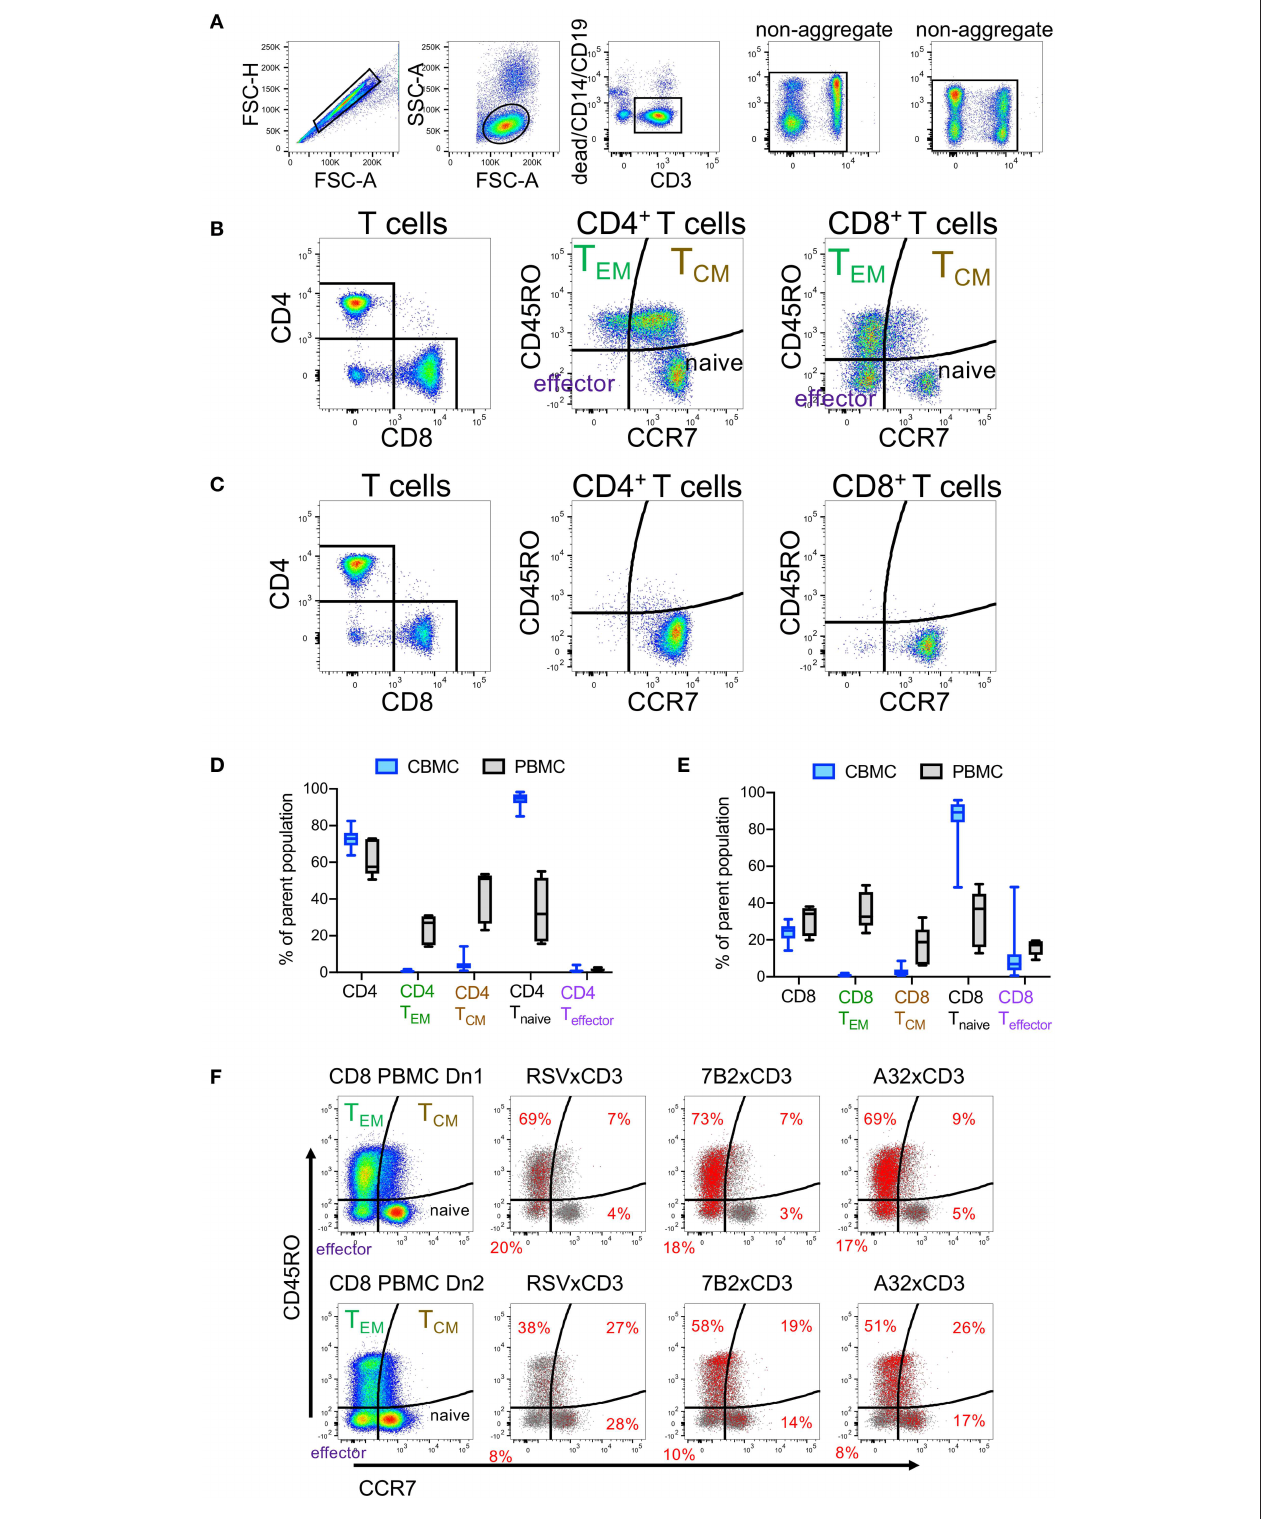
FIGURE 2 | Comparison of T cell subsets in adult peripheral blood mononuclear cells (PBMC) and cord blood mononuclear cells (CBMC) (A) Gating strategy. (B) Flow cytometry plots showing representative example of CD4 + and CD8 + T cell subsets among adult PBMC or (C) CBMC. Comparison of frequencies of (D) total CD4 + T